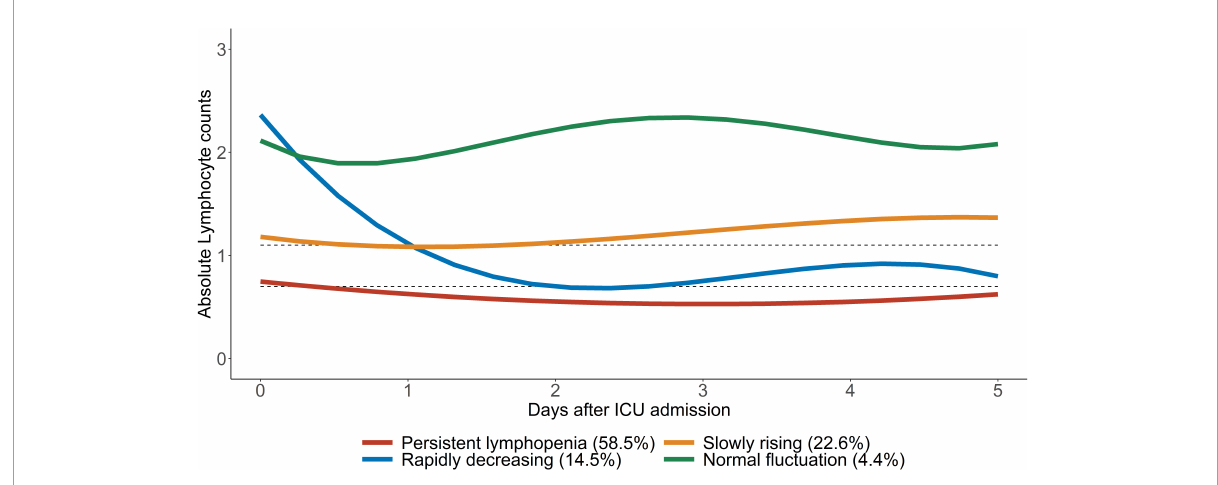
FIGURE3 Trajectories of ALC in critically ill patients. Four ALC trajectory endotypes were grouped in critically ill patients: persistent lymphopenia endotype, slowly rising endotype, rapidly decreasing endotype and normal fluctuation endotype. The upper gray dotted line represents 1.1 × 10 9 /L and the lower gray dotted line represents 0.7 × 10 9